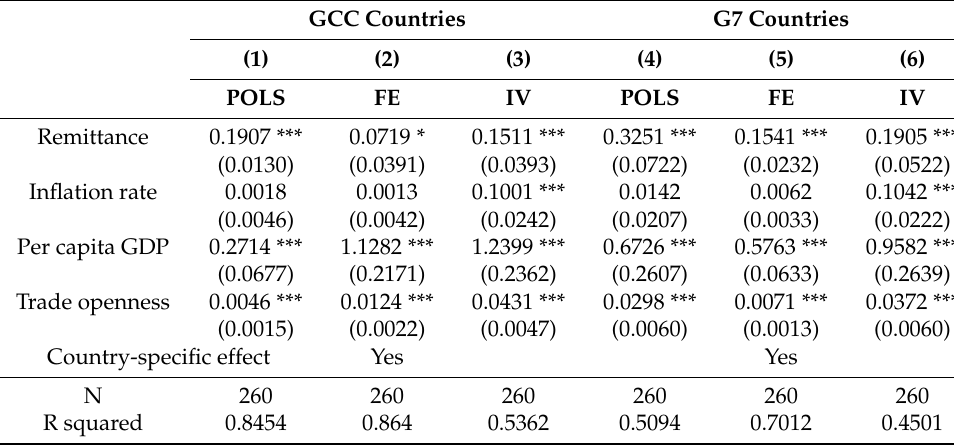
Table 3. Impact of remittance on gross savings to GDP